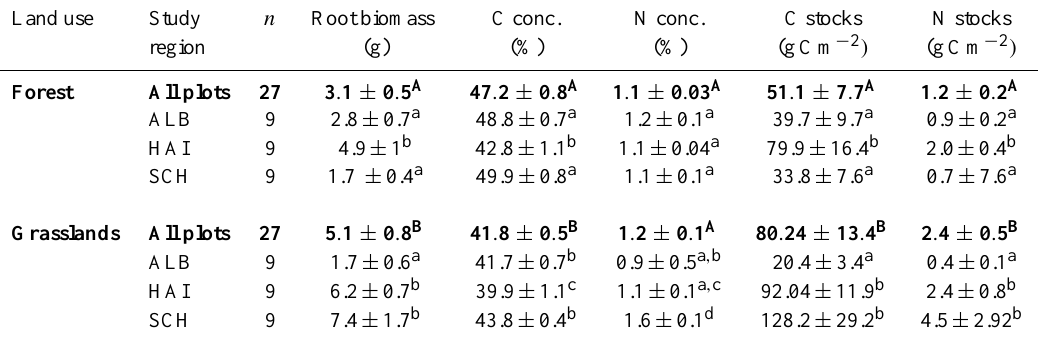
Table 2. Root biomass, C and N concentrations and C and N stocks in fine roots ( < 2mm) among different land uses and study regions (mean ± SE). Significant differences between study regions are indicated by lowercase letters and between land-use types by capital letters, according to Holm’s test ( p < 0.05).